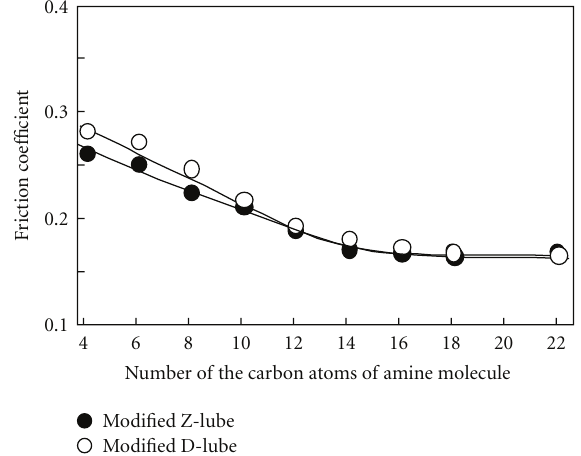
Figure 22: The relation between the number of carbon atoms and frictional coe ffi cient after 100 cycles of reciprocating